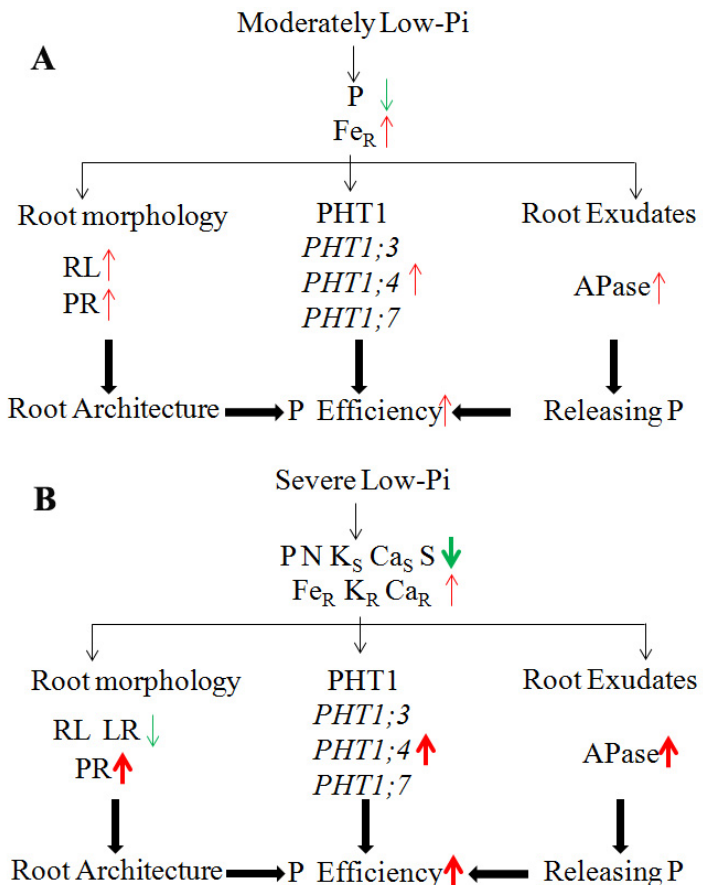
Figure 6. Adaptations through which the root system increased P efficiency at moderately low Pi ( A ) and severely low Pi ( B ). The size of each arrow represents the intensity. The red up arrow represents an increase. The green down arrow represents a decrease.